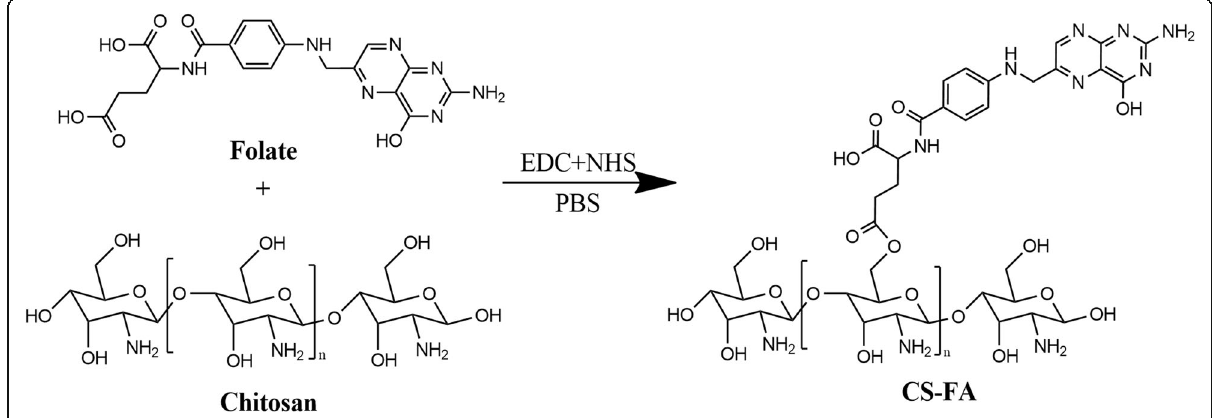
Fig. 1 Synthetic route of CS-FA conjugate